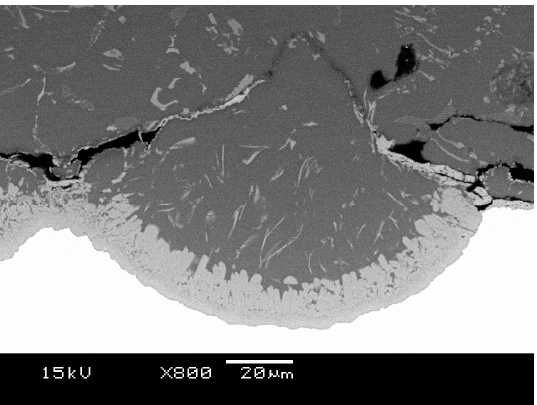
Figure 5. Polished section of the affected zone on the stainless steel plate (bottom white is stainless steel).